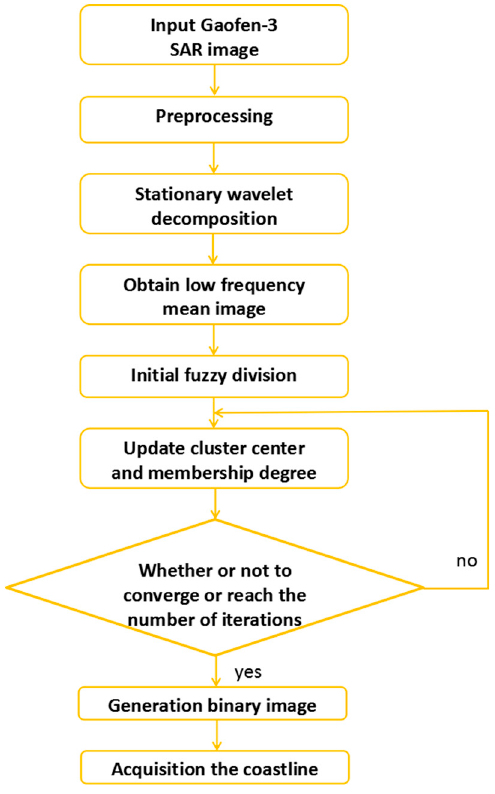
Figure 3. Flow chart of the improved Fuzzy C-means (FCM) algorithm.